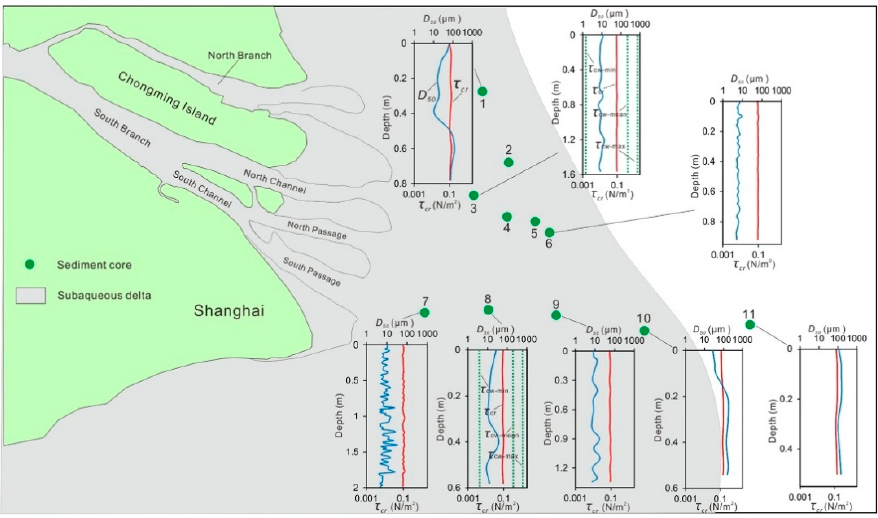
Figure 2. The critical shear stress in the Yangtze River subaqueous delta [17].